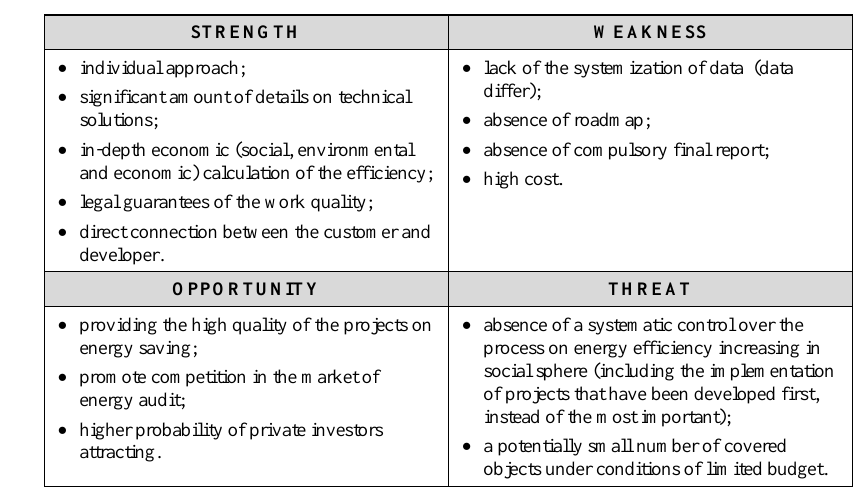
Fig. 1. SWOT-analyzes of element by element approach for developing energy saving